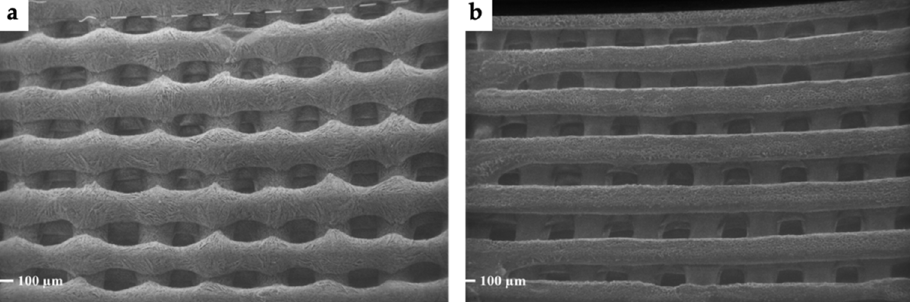
Figure 5. SEM micrographs representing ( a ) the top of the 3D VitE 1 scaffold and ( b ) the bottom of the 3D VitE 1 scaffold. Magnification 40×.